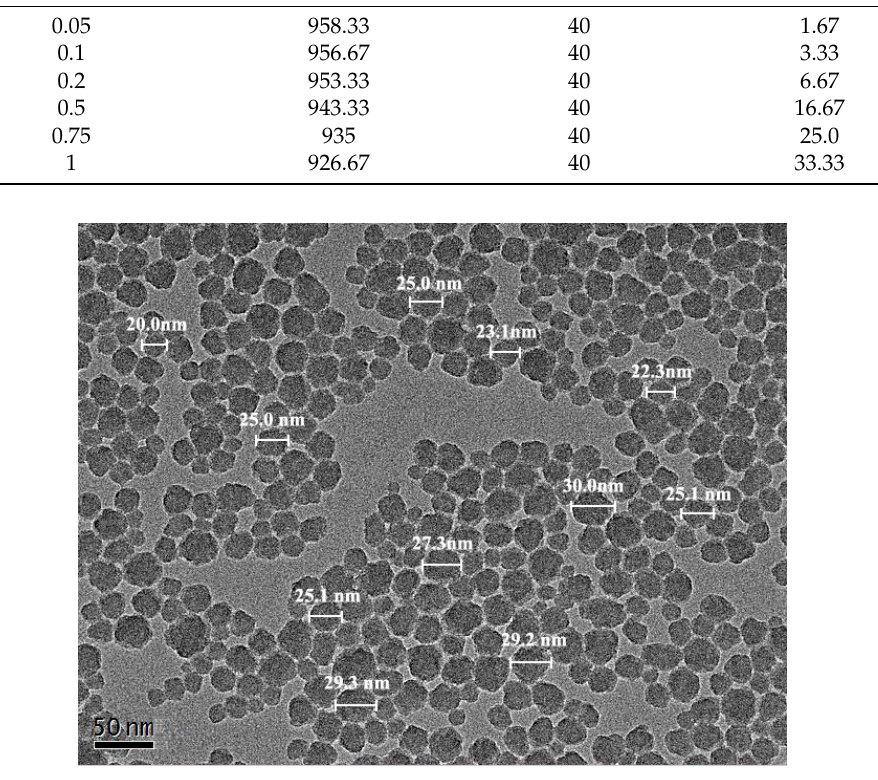
Figure 3. TEM image of silica nanofluid with an average size of 25 nm.